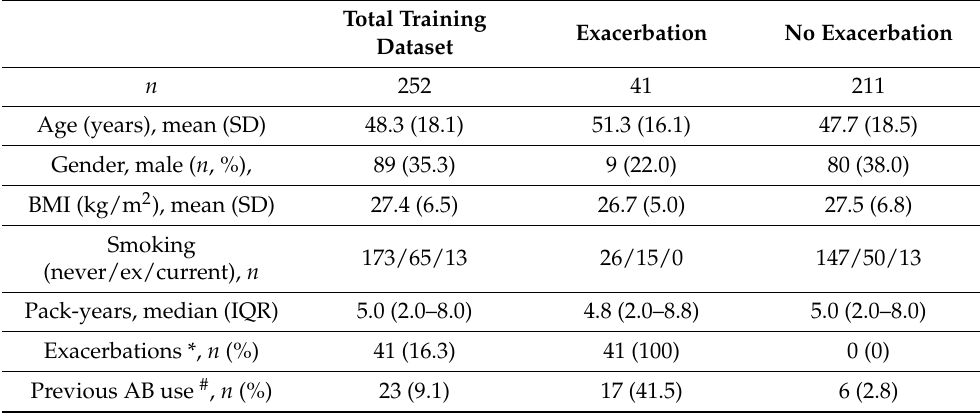
Table 1. Baseline characteristics of the training